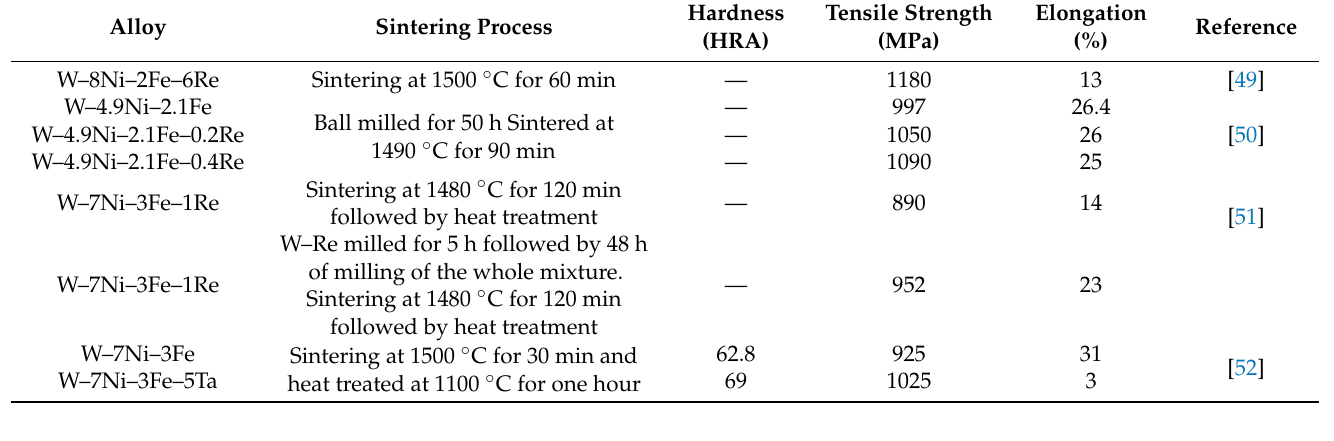
Table 2. Mechanical properties of the rhenium and tantalum added to the tungsten heavy alloy of W–Ni–Fe.